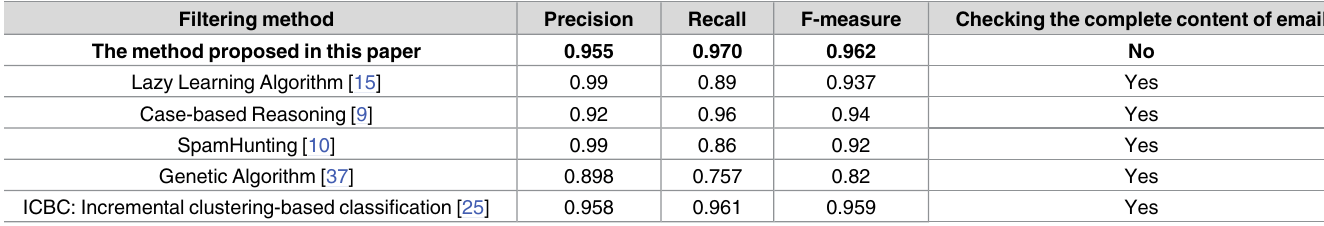
Table 7. The comparison of different spam filtering methods. Filtering